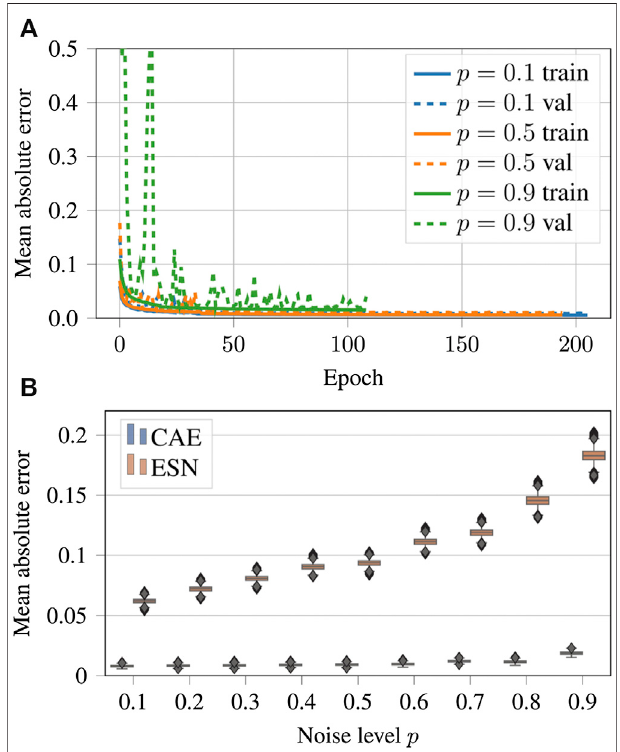
FIGURE 9 | (A) Evolution of the loss function values over the epochs for noisy input data generated with noise levels p (cid:2) 0 . 1, p (cid:2) 0 . 5, and p (cid:2) 0 . 9 (compare Figure 8 ). It can be seen that the training always ran up to the point where early stopping, as de fi ned in Section 3.1 , terminated it. The solid lines are the values of the loss function during training on the training data, while the dotted lines are the values of the loss function obtained when the trained model is applied to the validation data. One epoch trained approximately 110 s on a GTX 1080 Ti. (B) Comparison between CAE and ESN performance with noisy input data showing boxplots of mean absolute errors (18) for different noise levels p ∈ [ 0 . 1 , 0 . 2 , ... , 0 . 9 ] . Each discrete value on the x -axis is assigned to the boxes of the CAE and ESN, where the ESN boxplotsarecoloredinorangeandtheCNNboxplotsarecoloredinblue.Note that for better visibility the CAE boxes and the ESN boxes a slightly shifted to the left and to the right, respectively. A tabular overview of the values can be found in Table 3